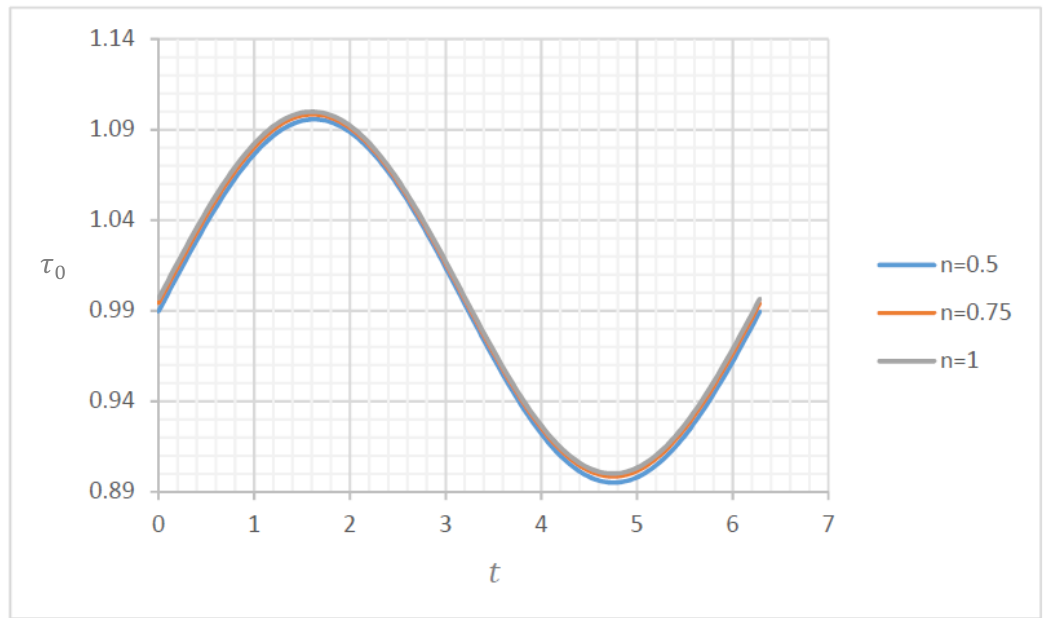
Figure 4. Wall shear stress for Ω = 0.1, Re = 1, ε = 0.1. Figure 4. Wall shear stress for  = 0.1 , 𝑅𝑒 = 1 , 𝜀 = 0.1 . Figure 4. Wall shear stress for  = 0.1 , 𝑅𝑒 = 1 , 𝜀 = 0.1 .